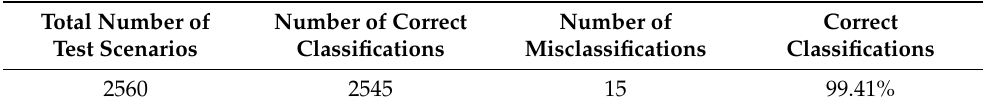
Table 9. Classification results for the generated random forest.